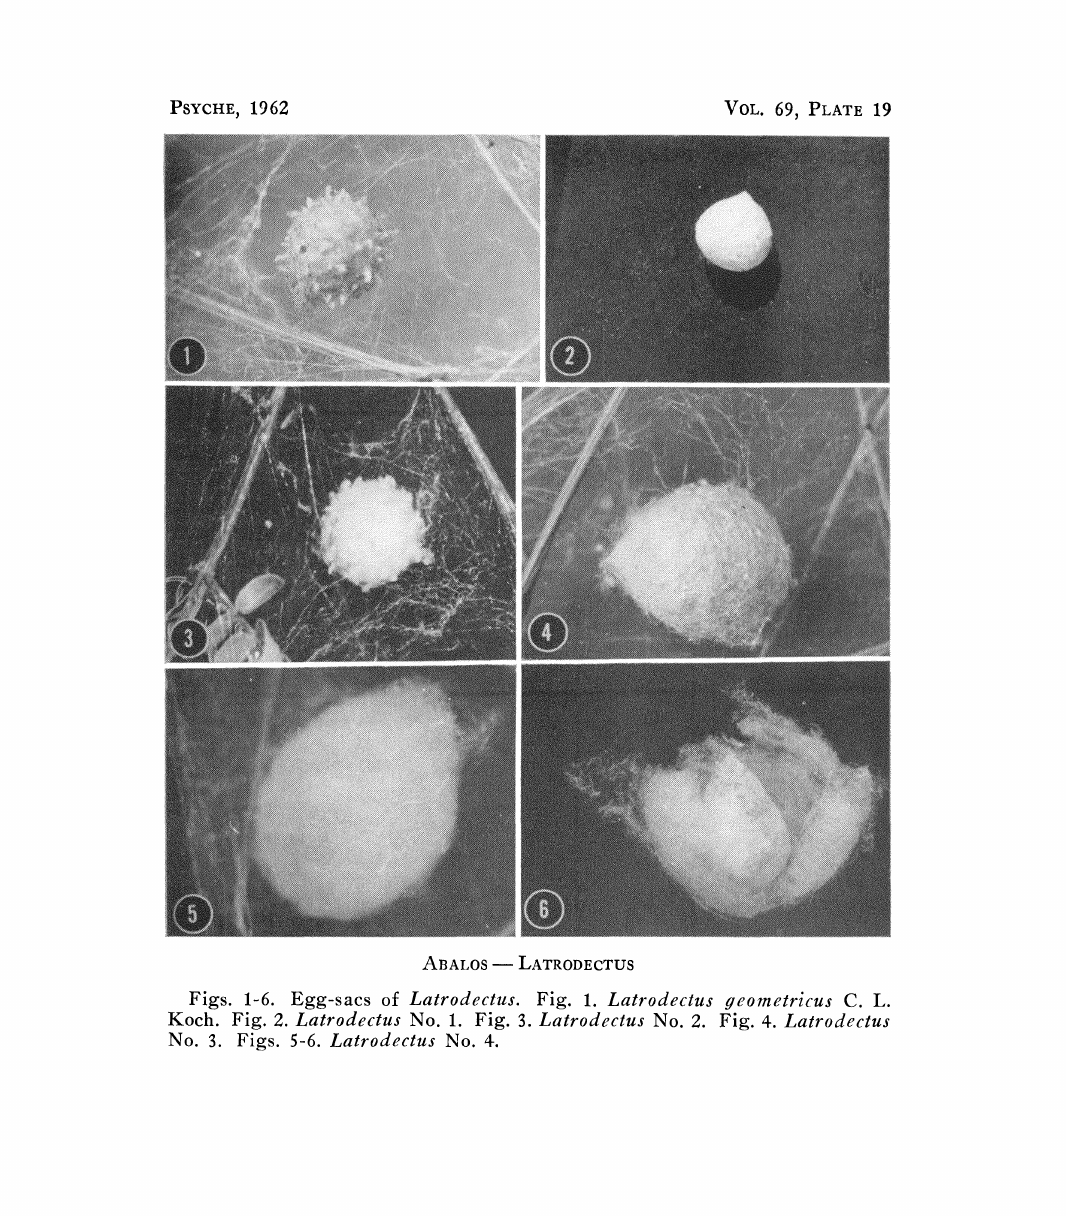
Figs. 1-6. Egg-sacs of Latrodectus. Fig. 1. Latrodectus geometricus C. L. Koch. Fig. 2. Latrodectus No. 1. Fig. 3. Latrodectus No. 2. Fig. 4. Latrodectus No. 3. Figs. 5-6. Latrodectus No.